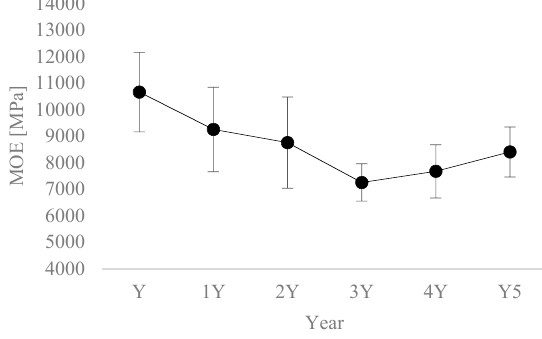
Figure 4. Modulus of elasticity (MOE) of spruce wood in reference to the time since the tree’s decay. Higher mean values of MOR (89.85 MPa) and MOE (10,679 MPa) were achieved in the wood of Table 2. Statistical properties of resistance to static bending (MOR) and modulus of elasticity (MOE) in Norway spruce wood in reference to time which has elapsed since the tree’s decay.